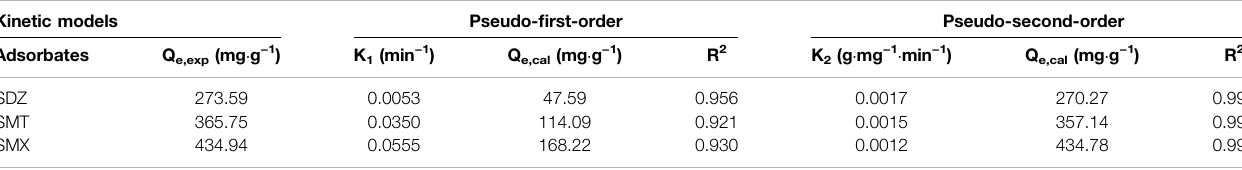
TABLE 2 | Adsorption kinetics parameters of SAs on 50MBC-KOH 2.5 . Kinetic models